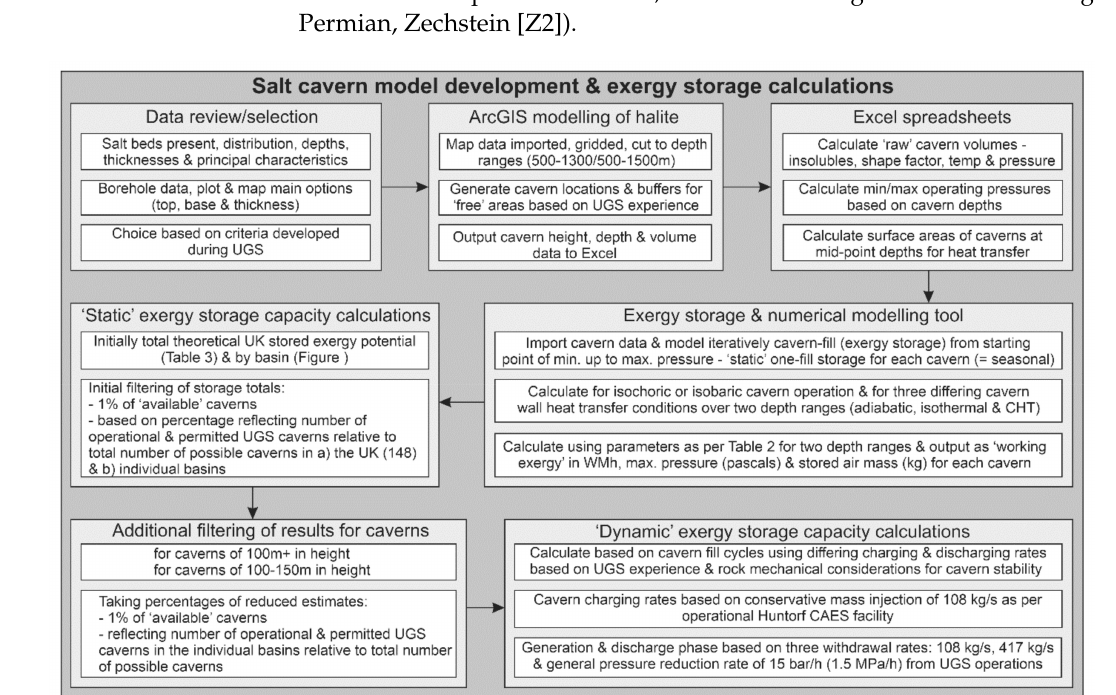
Figure 2. Workflow for the estimation of exergy storage provided by solution-mined salt caverns in the main halite-bearing basins of the